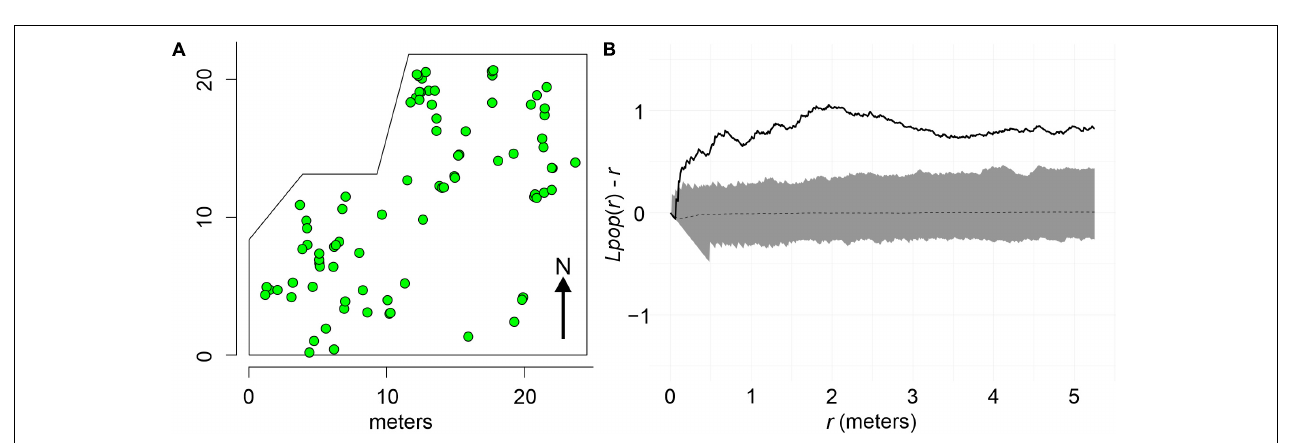
FIGURE 3 | (A) Spatial distribution of P. strigosa colonies at the Picudas site. (B) Clustered spatial pattern of P. strigosa colonies as indicated by Besag’s transformation plot of Ripleys K of colony pattern distribution. The spatial pattern of the sample (solid line) falls outside the 95% confidence envelope (shaded area) of a complete spatial random pattern (dotted